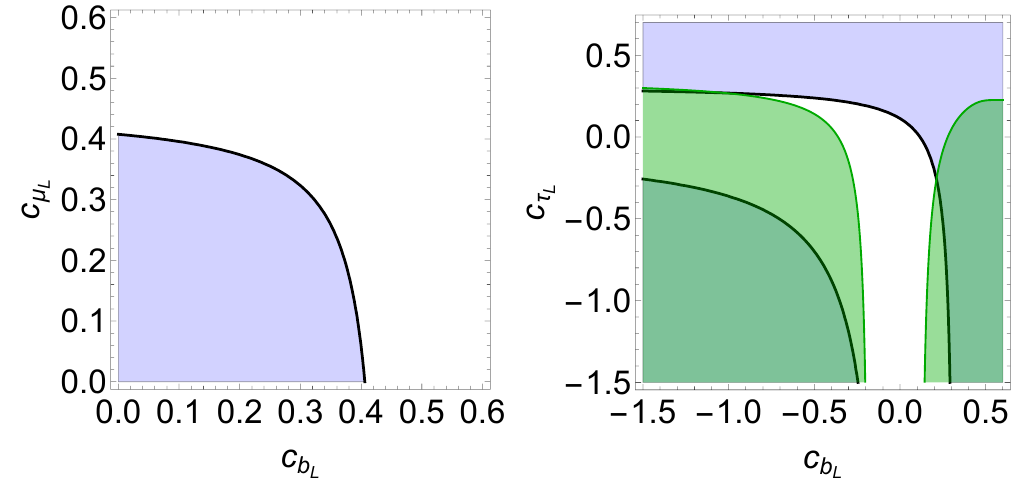
. ; c (cid:22) ) by the condition R (cid:22)=e D ( (cid:3) ) L L [0 : 996 ; 1 : 008] in 2